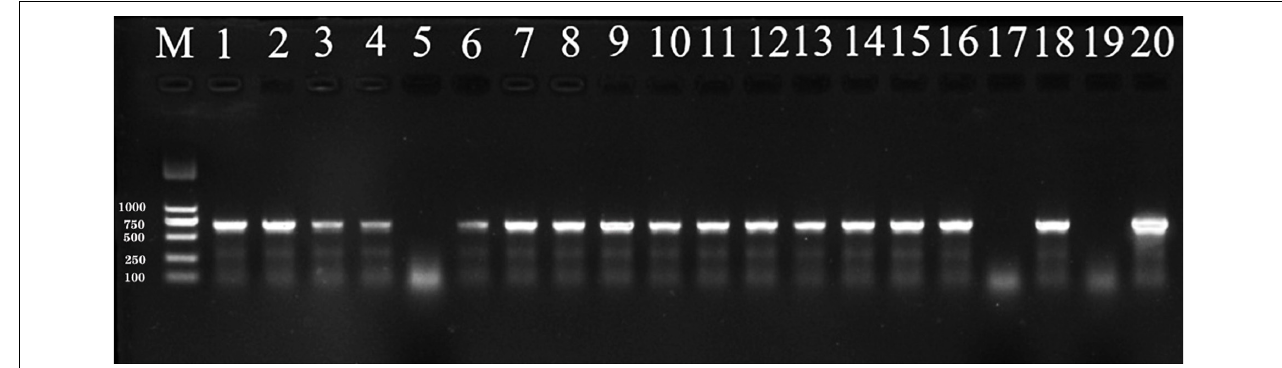
FIGURE 5 | PCR products amplified from DNA extracted from sorghum seedings and visualized by 1% agarose gel electrophoresis. Sorghum seeds were planted in soil containing 0.2% (by weight) teliospores of S. reilianum . After 3 days of incubation at 10 ◦ C, 20% soil moisture, and 60% relative humidity, the planted seed trays were transferred to a greenhouse (25 ◦ C and a 12-h light/dark cycle) for 4 days after which the seedlings were collected for DNA extraction. Lane M: DNA ladder DL2000. Lane 1–18: sorghum seedings. 19: negative control (Seedlings from pathogen-free soil); 20: positive control (DNA from S. reilianum mycelia).